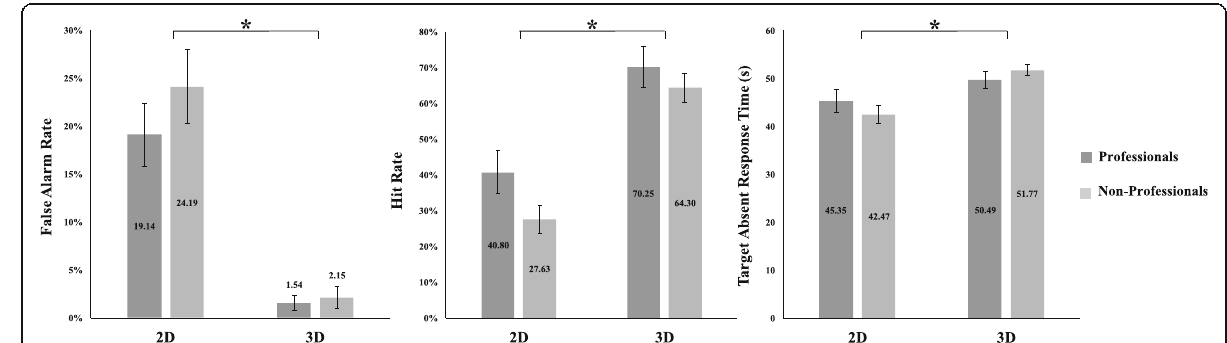
Fig. 2 Key measures for professionals and non-professionals in 2D and segmented-3D visual search in Experiment 1. The asterisks indicate a main effect of display type: false alarm rates were lower, hit rates were higher, and target-absent response times were longer for segmented-3D displays compared to 2D displays. Error bars represent the standard error of the